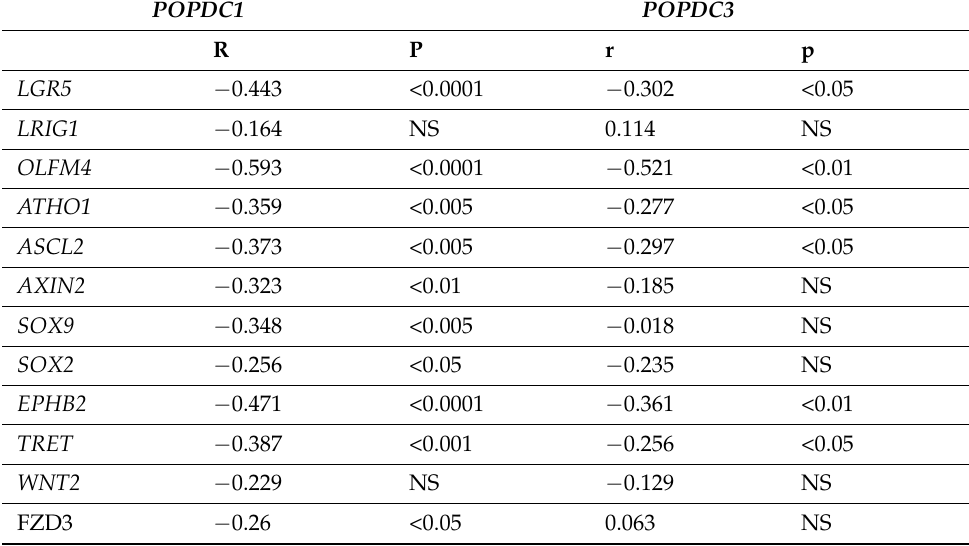
Table 2. Summary of correlation analyses between transcript levels of POPDC1 and POPDC3 and those of the genes depicted in Figure 7. Spearman’s correlation